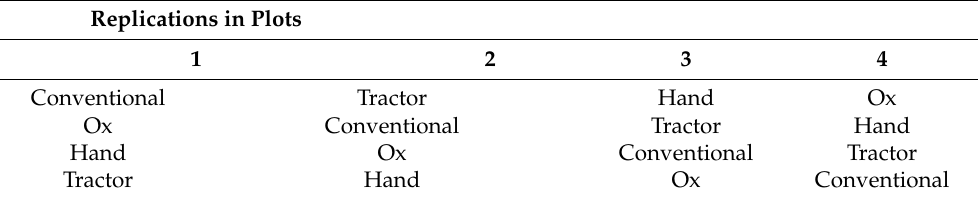
Table 1. Design layout of ploughing treatments. Replications in